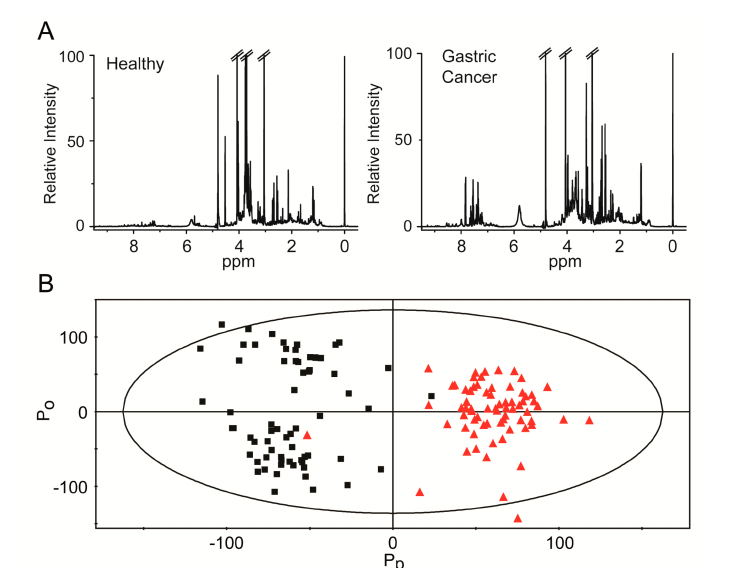
Figure 1. Representative 1 Hnuclearmagneticresonance(NMR)spectraofurinesamplesanddiscrimination between healthy control and gastric cancer groups. ( A ) Typical 1 H NMR spectra with an internal standard signal (0.025% TSP) at 0 ppm. The left panel shows a representative 1 H NMR spectrum for healthy controls, and the right panel shows a representative 1 H NMR spectrum for patients with gastric cancer. ( B ) Orthogonal projections to the orthogonal projection for a latent structure-discriminant analysis (OPLS-DA) score plot of the healthy control and gastric cancer groups. The model was constructed with one predictive ( P p ) and two orthogonal ( P o ) components. The overall goodness of fit and cross-validation coefficients are 86.5 and 72.8%, respectively. Black boxes: samples from healthy controls; red triangles: samples from patients with gastric